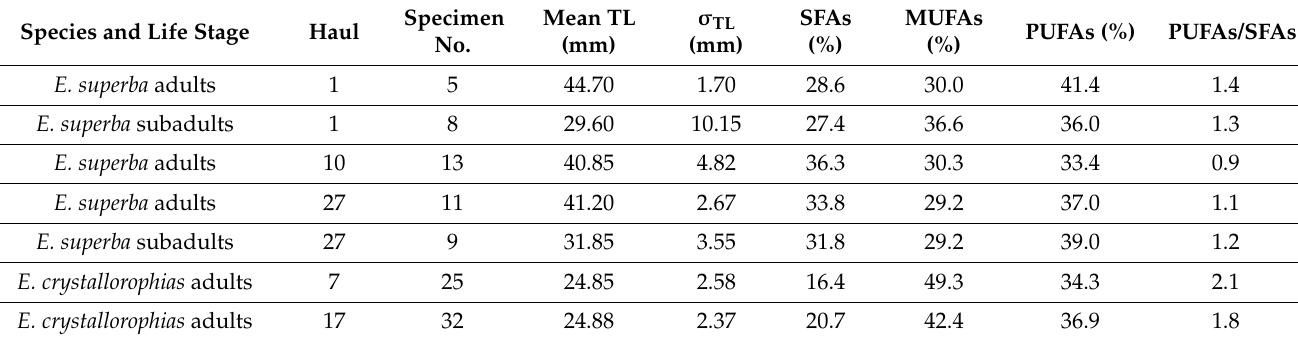
Table 3. Krill specimens used for fatty acid characterisation, their length measurements, content in SFA, MUFA, and PUFA and PUFA/SFA ratio. TL = total length, σ TL = standard deviation, SFA = sat- urated fatty acids, MUFA = mono-unsaturated fatty acids, PUFA = polyunsaturated fatty acids.